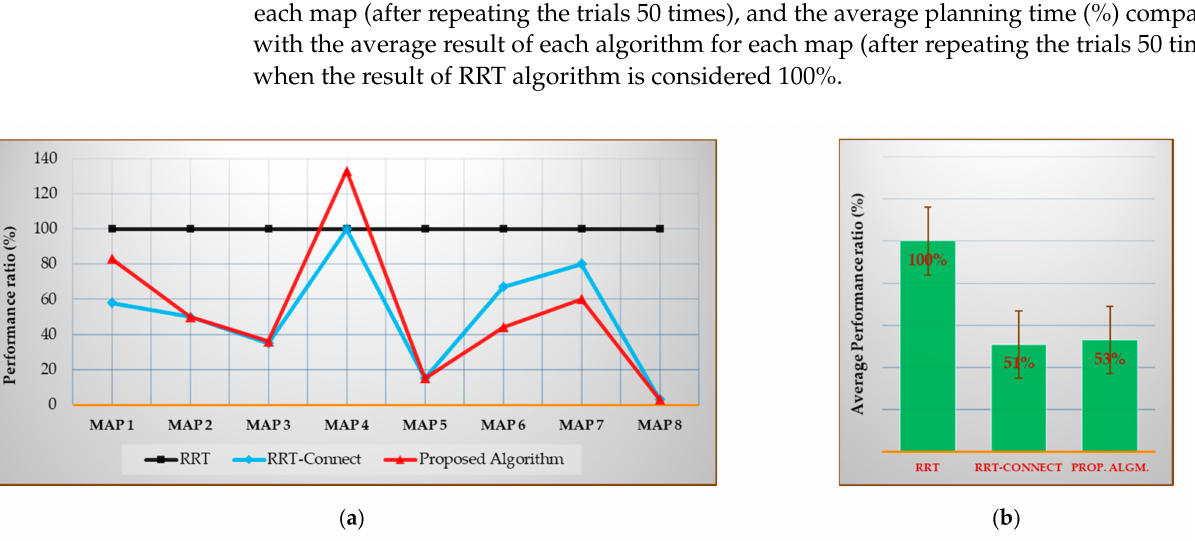
Figure 21. Experimental results in total on the average planning time: ( a ) result of each map compared with the RRT algorithm ( x cmp ( i ) ); ( b ) average result compared to the RRT algorithm ( X cmp